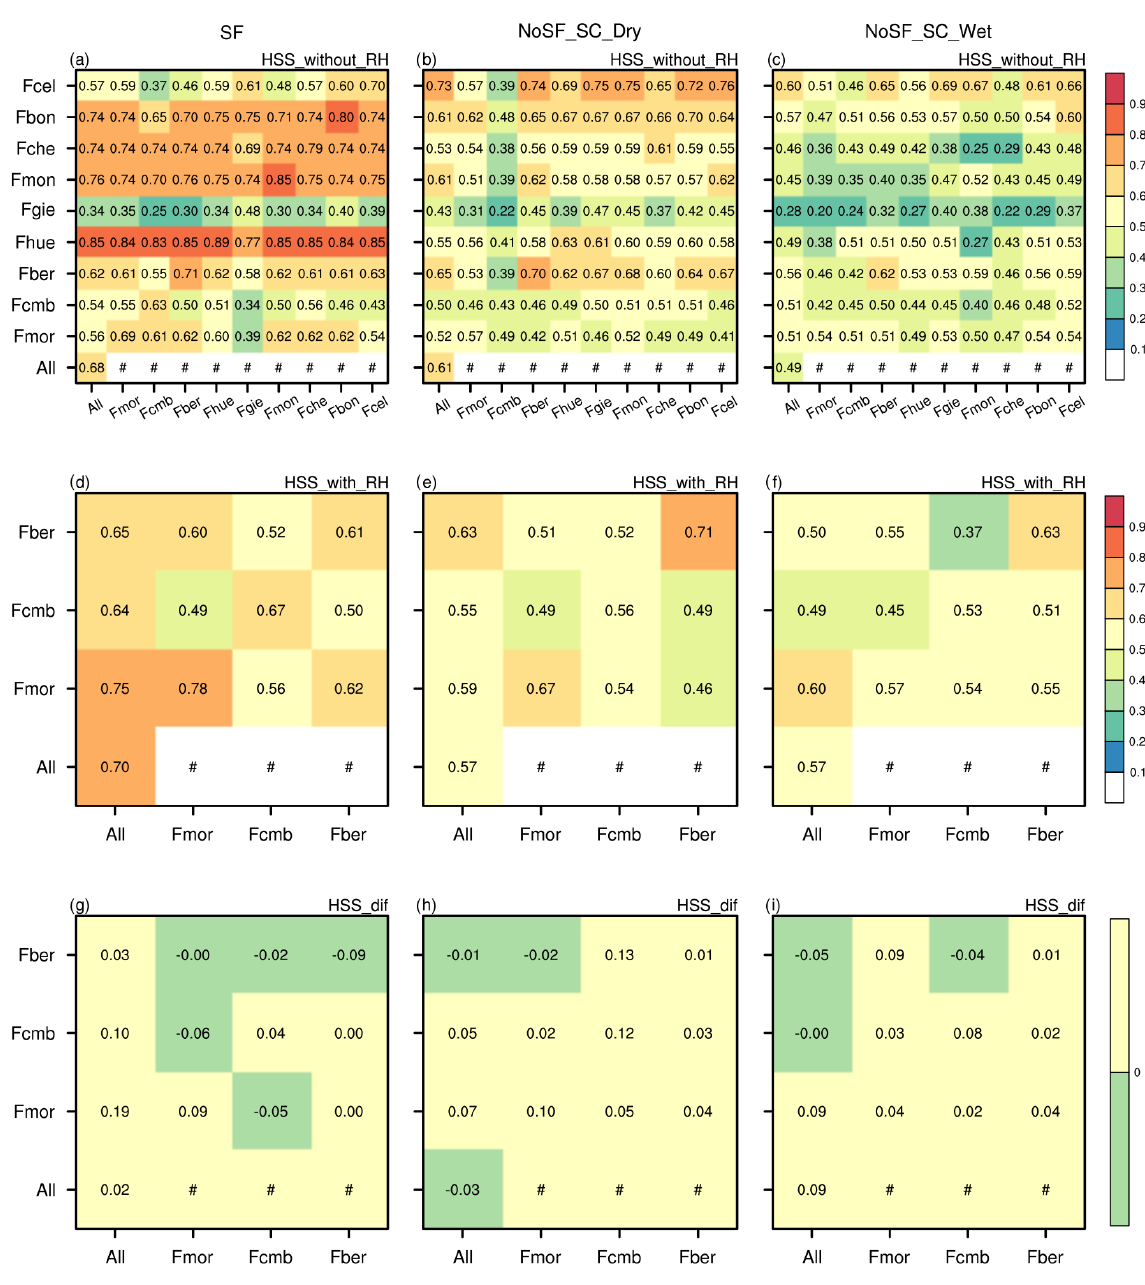
Figure 9. The same as Fig. 4 but for the